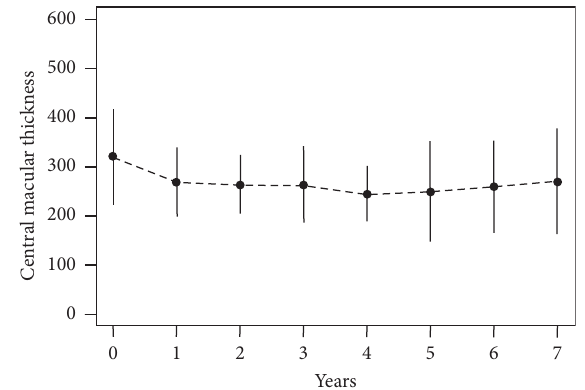
Figure 3: Mean change of central macular thickness for all eyes measured by spectral domain-optical coherence tomography B- scans over